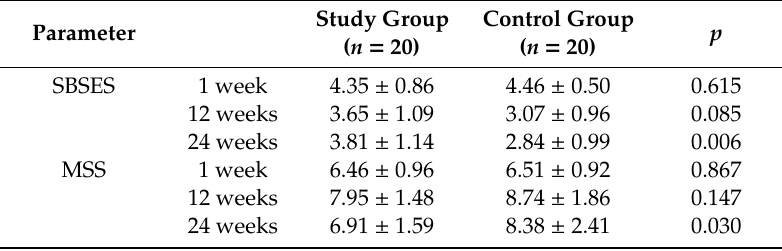
Table 2. Mean and standard deviation Stony Brook Scar Evaluation Scale (SBSES) and Manchester Scar Scale (MSS) scores of the study (Botox) and control (saline) groups (N = 40).